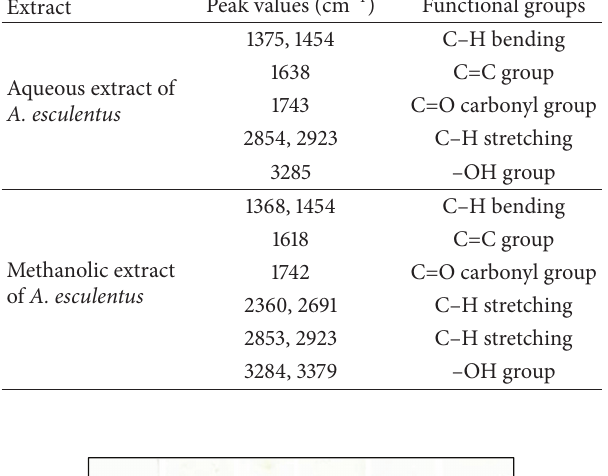
Table 1: FTIR spectral peak values and functional groups obtained. Extract Peak values (cm